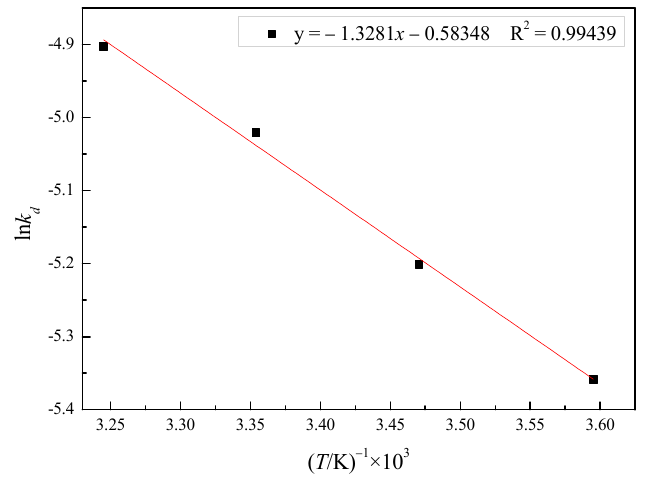
Figure 10. Arrhenius plot of the reaction rate against the reciprocal of temperature (278 to 308 K).